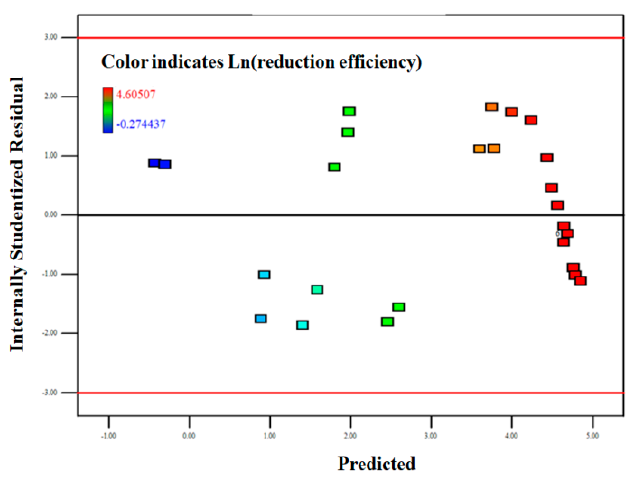
Figure 7. Plot of the residual responses vs. the predicted responses.